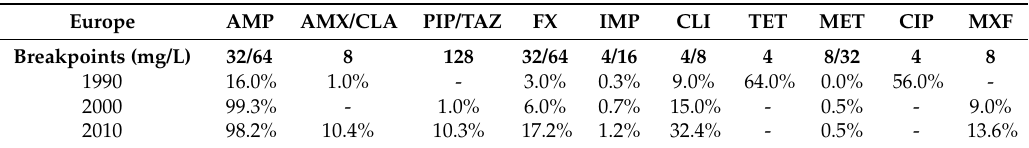
Table 6. Resistance trends of clinical Bacteroides isolates in Europe between 1990–2010 (expressed as the percentage of resistant isolates) [94,135,145].